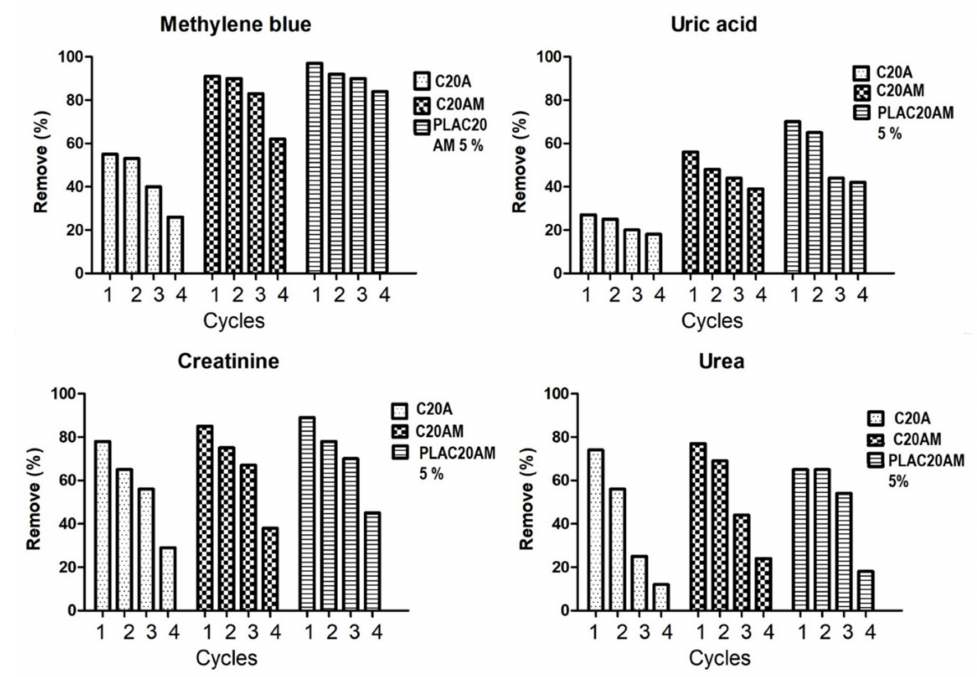
Figure 14. Effect of desorption cycles on methylene blue removal (MB concentration = 200 mg/L, nanoclay and nanocom- posite content = 20 mg/100 mL, T = 25 ◦ C and 60 min) or uremic toxins (uric acid, urea, creatinine concentration = 160 mg/L, nanoclay and nanocomposite 20 mg/100 mL and t = 60